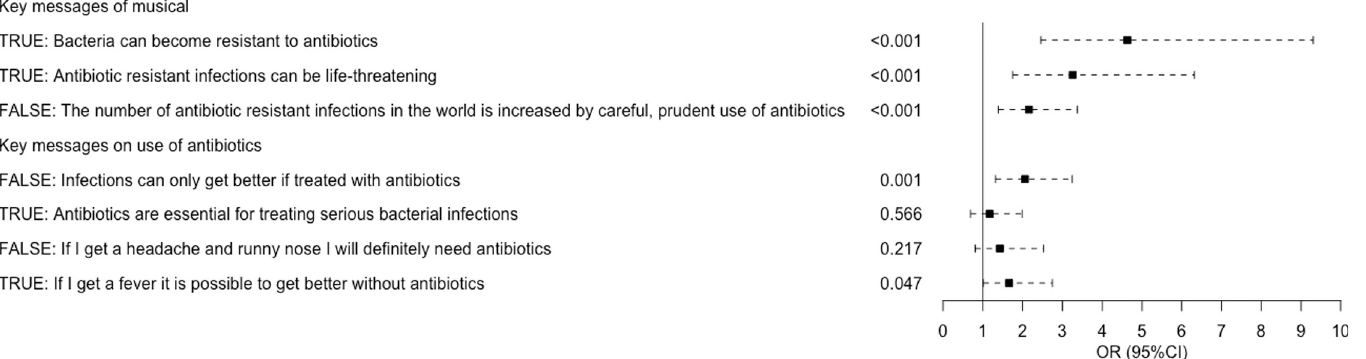
Fig 2. Improvement in children’s knowledge pre- musical and two weeks post-musical. Impact of musical on knowledge in primary school children (n = 161) using a generalised linear model accounting for confounding factors of prior knowledge, exposure to antibiotics, school year and school attended. Prior knowledge of AMR was a significant confounding factor in questions “Antibiotic resistant infections can be life-threatening”, “Infections can only get better if treated with antibiotics” and “If I get a headache and runny nose I will definitely need antibiotics”. School attended was a significant confounder in questions “The number of antibiotic resistant infections in the world is increased by careful, prudent use of antibiotics”, “Antibiotics are essential for treating serious bacterial infections” and “If I get a headache and runny nose I will definitely need antibiotics”.